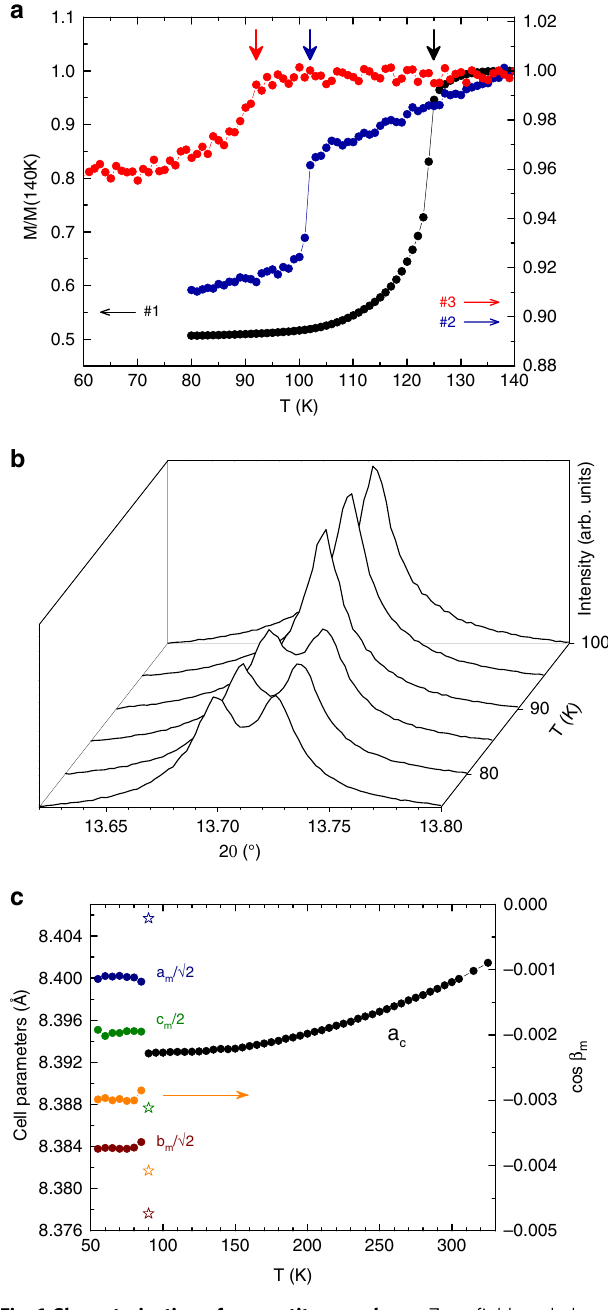
Fig. 1 Characterisation of magnetite samples. a Zero- fi eld cooled magnetisations of the powder for sample #1 and the microcrystals #2 and #3, normalised to 140 K values. The fi elds used were 100 Oe (#1 and #2) and 500 Oe (#3). The Verwey transition for each sample is indicated by a vertical arrow. b Low-temperature splitting of the cubic- (440) powder X-ray diffraction peak for sample #3, demonstrating that a lattice distortion occurs at the Verwey transition between 85 and 90 K. c Thermal evolution of unit-cell parameters derived from fi ts to powder X-ray pro fi les for #3 showing the monoclinic splitting at low temperatures. Values for sample #1 at 90 K 8 , shown as stars, demonstrate that the magnitude of the monoclinic distortion is greatly reduced by